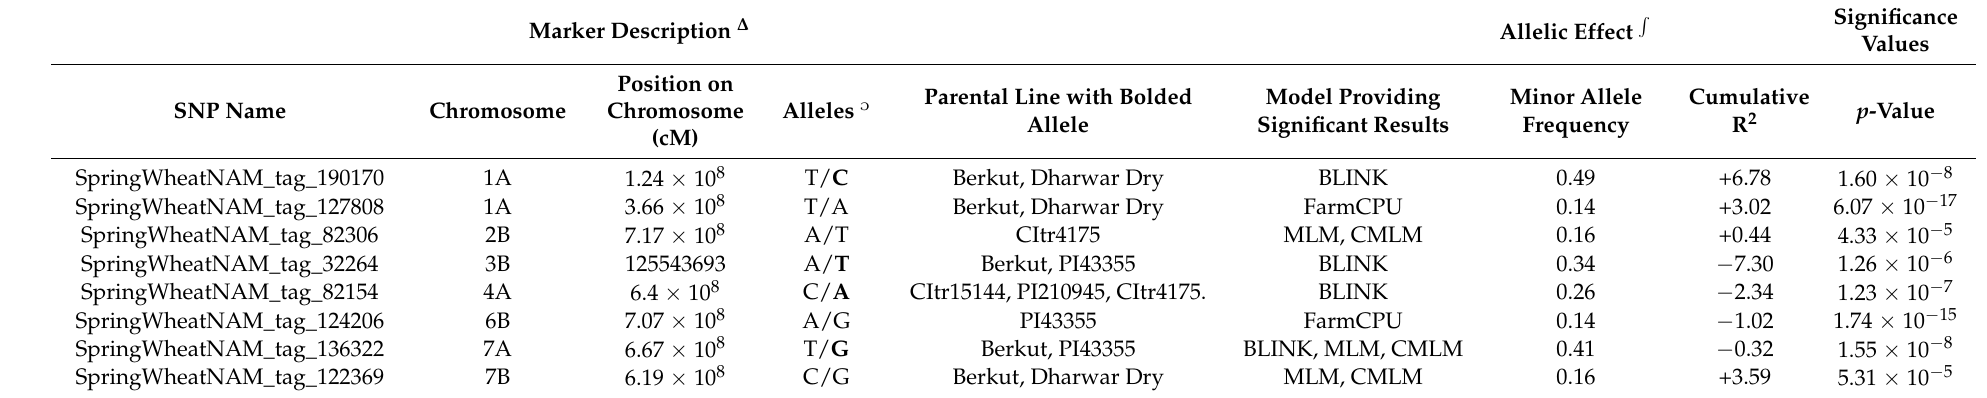
Table 2. Significant markers representing quantitative trait loci for grain protein content in a nested association mapping of hard spring wheat. Marker Description ∆